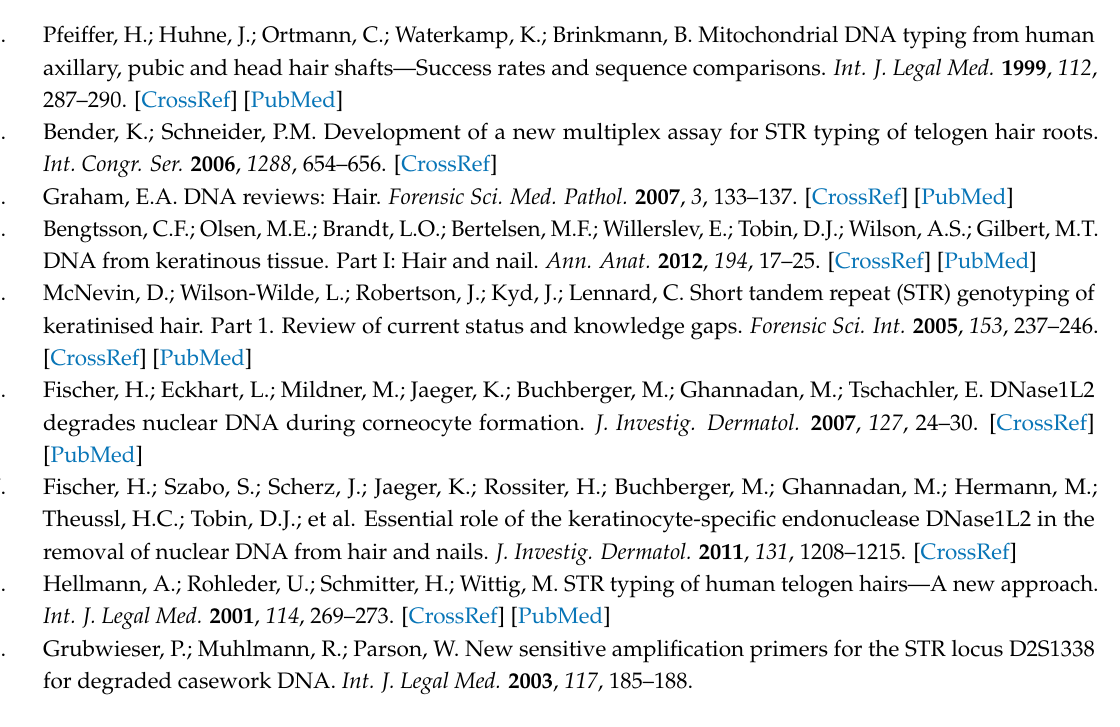
Figure S1: Comparison between the control region and the mtGenome coverage; Table S1: Global mtDNA qPCR results; Table S2: Coverage of the mtGenome for recent and aged hairs and hair segments; Table S3: Sequencing statistics for all recent and aged hairs; Table S4: Difference between shotgun sequencing and sequencing of libraries enriched for mtDNA; Table S5: The derived and ancestral Y haplogroup diagnostic SNPs that were observed for Sample A2*. Protocols: description of protocols A, B and C; CLC Workflow: workflow used to map reads to the